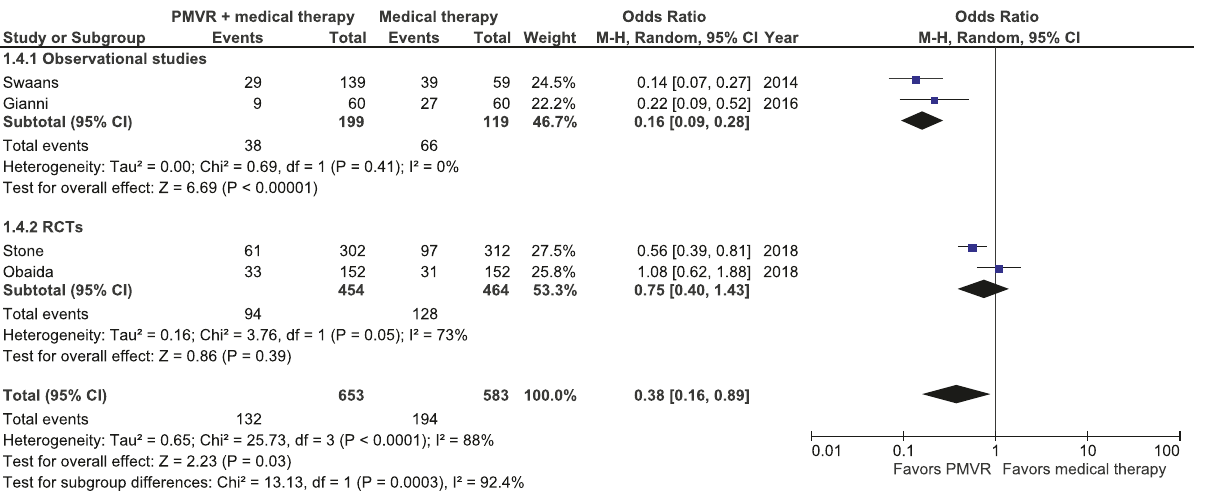
Figure 5: Forest plot displaying the risk of cardiovascular mortality in the PMVR group compared to the OMT